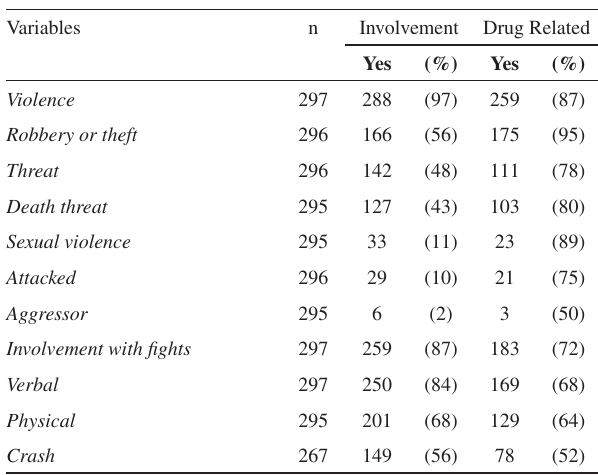
Table 3 - Behavioral violence variables and their relationship to drugs (use or